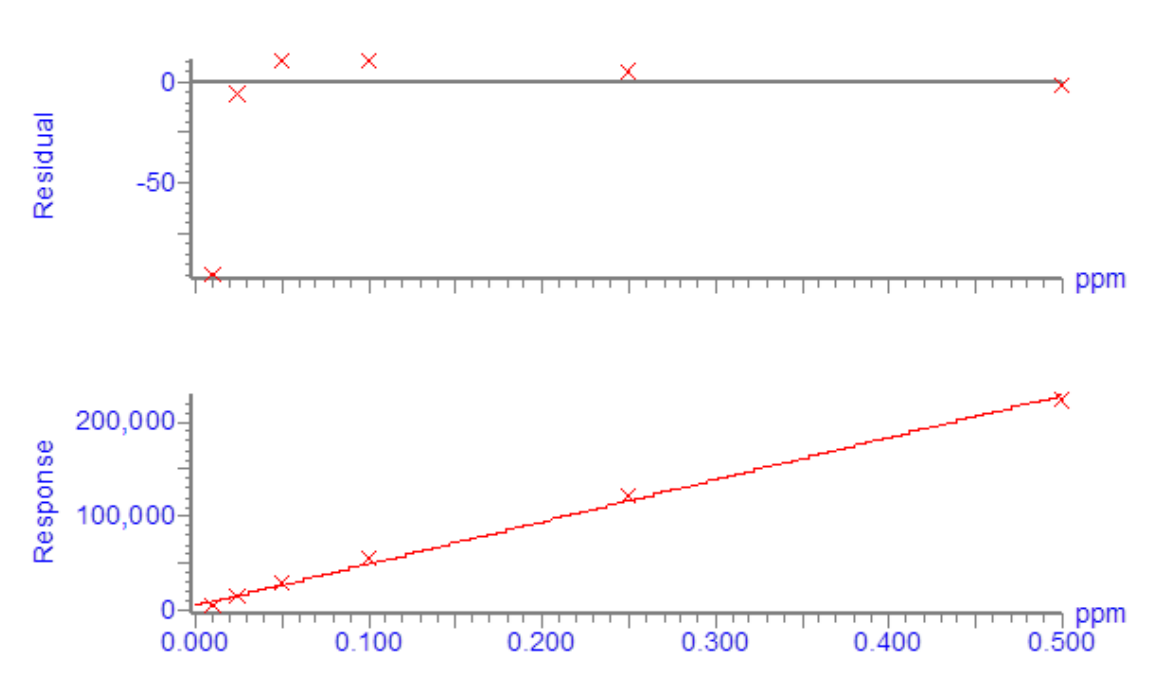
Figure 1. Calibration curve in solvent generated from the analysis of pure histamine standard solutions at concentrations from 10 to 500 ng/mL.